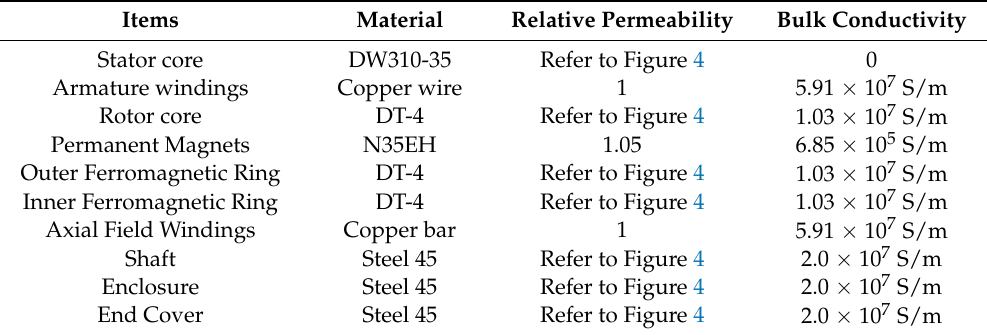
Table 2. Material properties for electromagnetic field analysis.